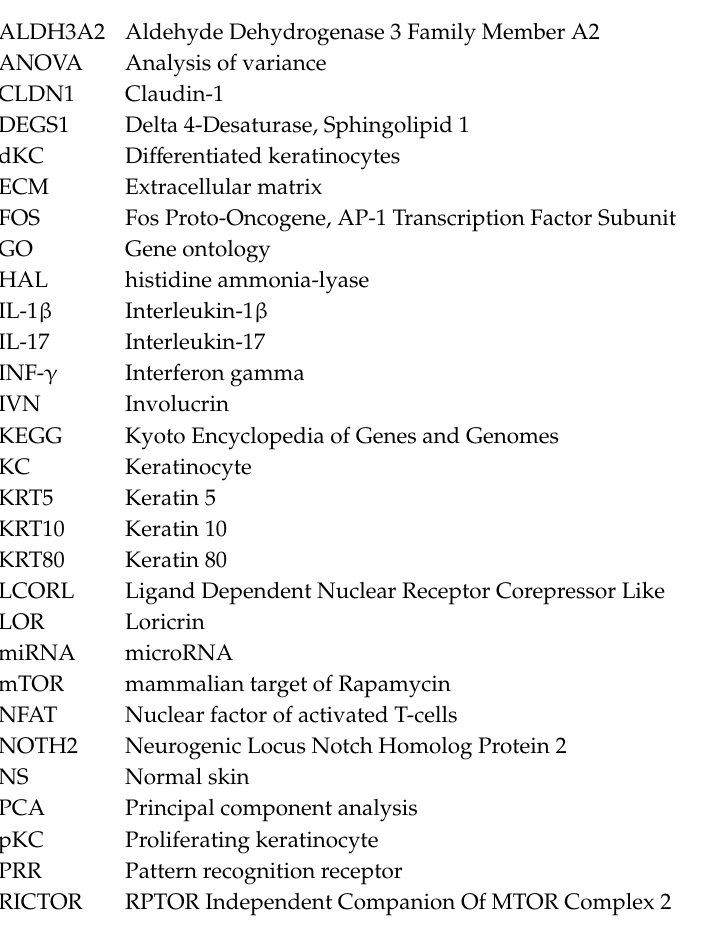
s1. Table S1. miRNAs di ff erentially expressed between pKC and SE; Table S2. miRNAs di ff erentially expressed between pKC and dKC; Table S3. miRNAs di ff erentially expressed between dKC and SE; Table S4. mRNAs di ff erentially expressed between the epidermis of psoriatic skin lesions and healthy skin; Table S5. miRNAs di ff erentially expressed between the epidermis of psoriatic skin lesions and healthy